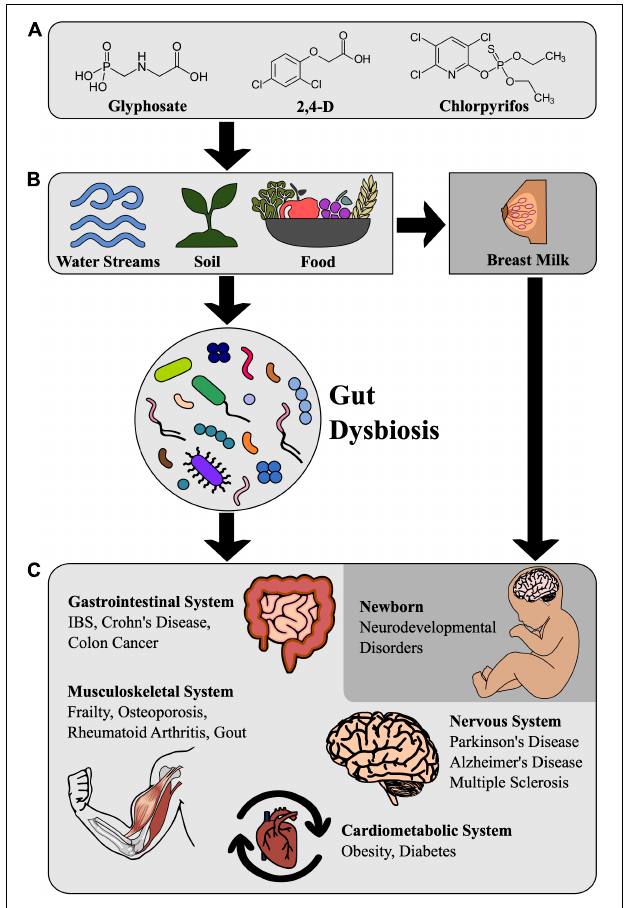
FIGURE 1 | Pesticide-Triggered dysbiosis and impact on human health. (A) Structural formulae of widely used pesticides. (B) Pesticide residues in soil, water sources, and food can cause gut dysbiosis in humans. Pesticide residues in breast milk can also impair infant neurodevelopment. (C) Health consequences of intestinal dysbiosis caused by contamination with pesticide